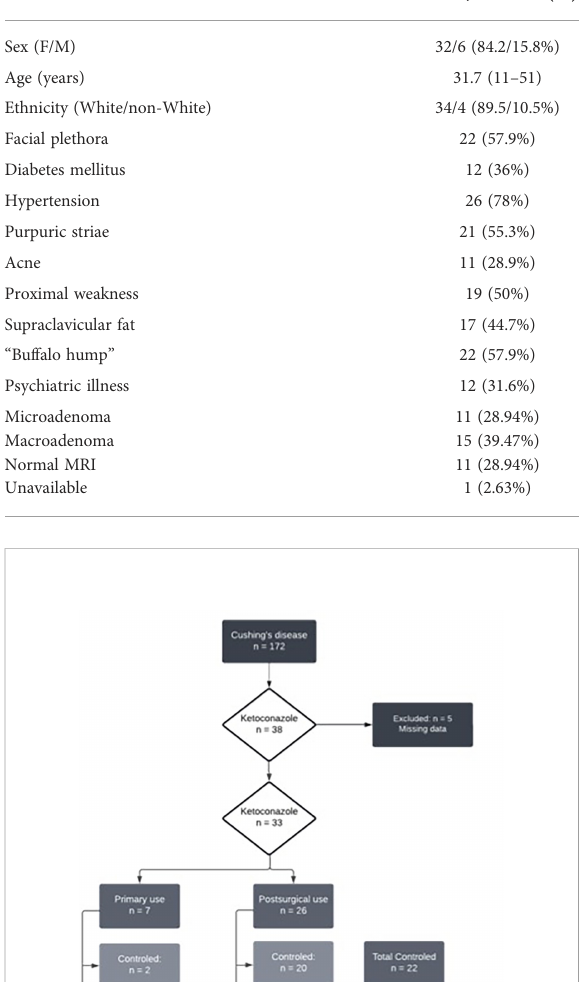
TABLE 1 Baseline clinical data of Cushing ’ s disease patients treated with ketoconazole.